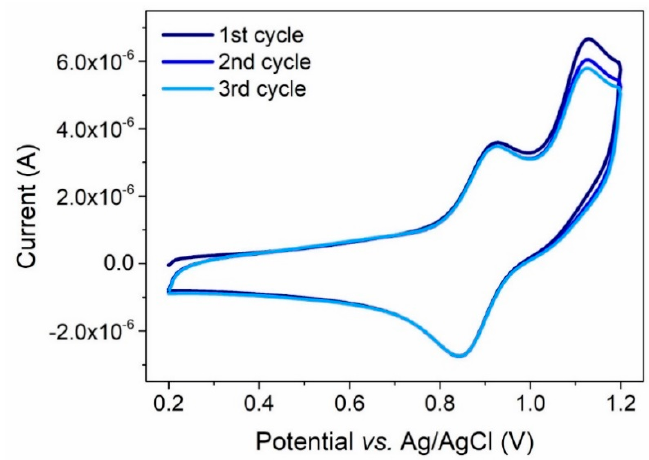
Figure 9. Cyclic Voltammetry plot relative to compound DF90 in CH 2 Cl 2 solution.